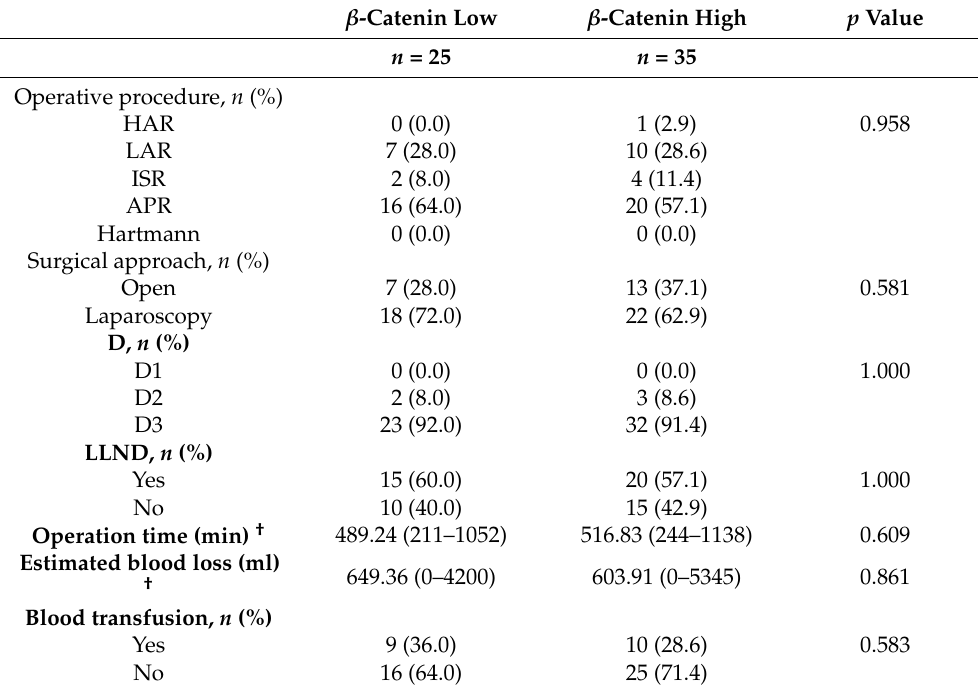
Table 2. Operative outcomes.